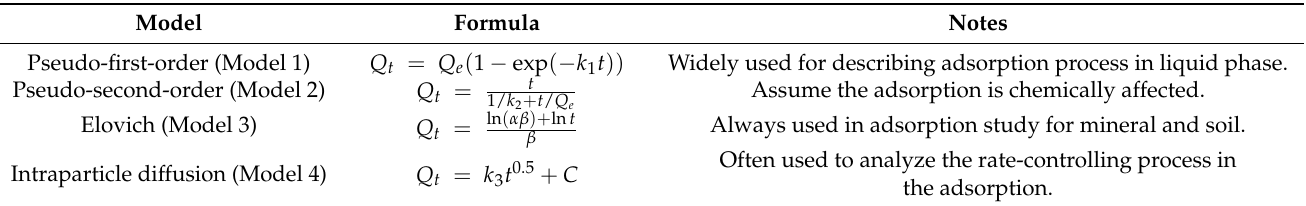
Table 1. Four adsorption models used in this study.